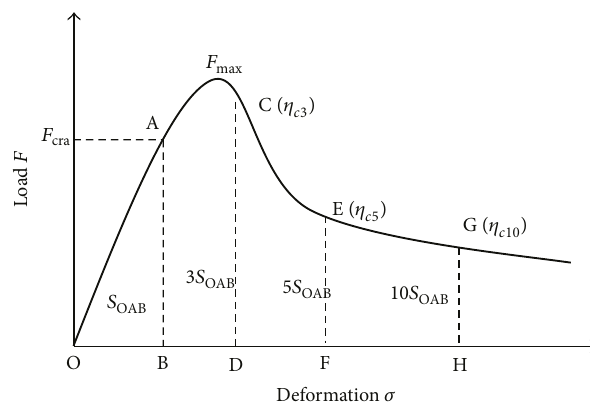
Figure 17: The stress-strain curve and toughness index.